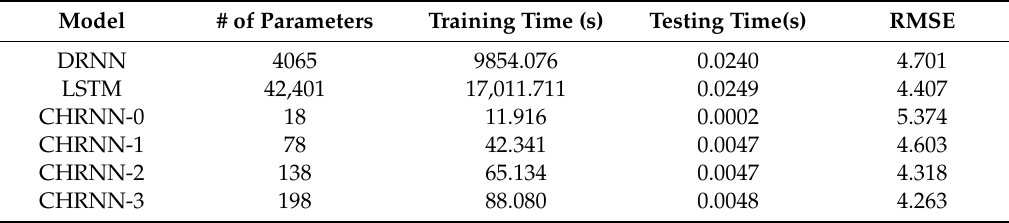
Table 7. Prediction results for ChungMing between the deep recurrent neural network (DRNN),